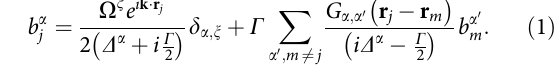
of 10 12 cm (cid:2) 3 . However, the measured density shift for the red